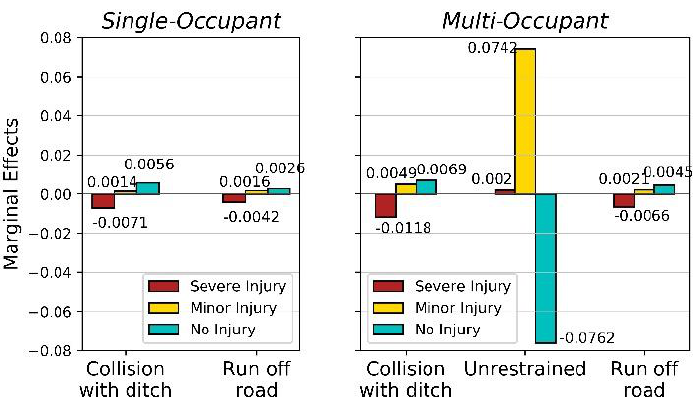
Safety 2020 , 6 , 30 Figure 1. Estimated marginal e ff ects of Crash Characteristics. Figure 1. Estimated marginal effects of Crash Characteristics.